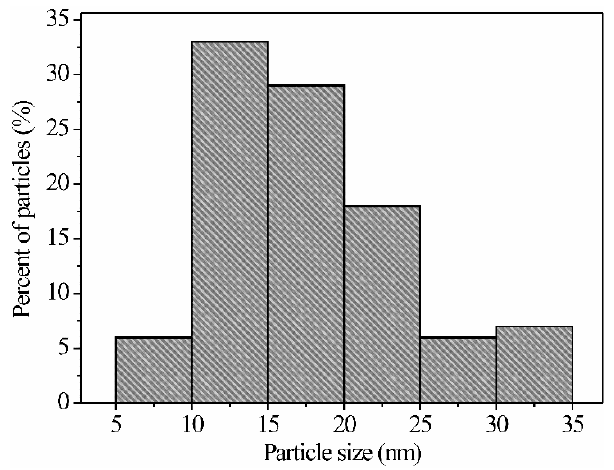
Figure 8 . Nanoparticle size distribution for the ZnAl 2 O 4 calcined at 300 °C.